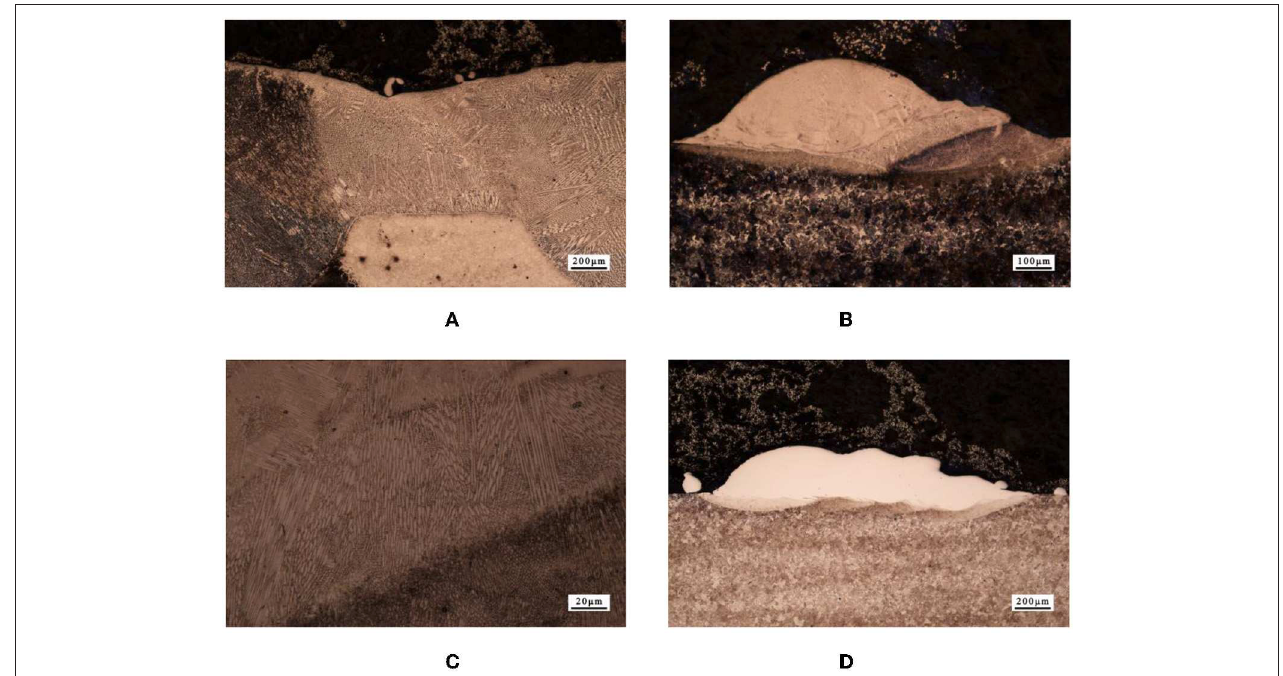
FIGURE 4 | Microstructure of multi-track layers. (A) Overlapping area of double-track LMD layer; (B) double-track EHLMD layer; (C) overlapping area of double-track EHLMD layer; (D) four-track EHLMD